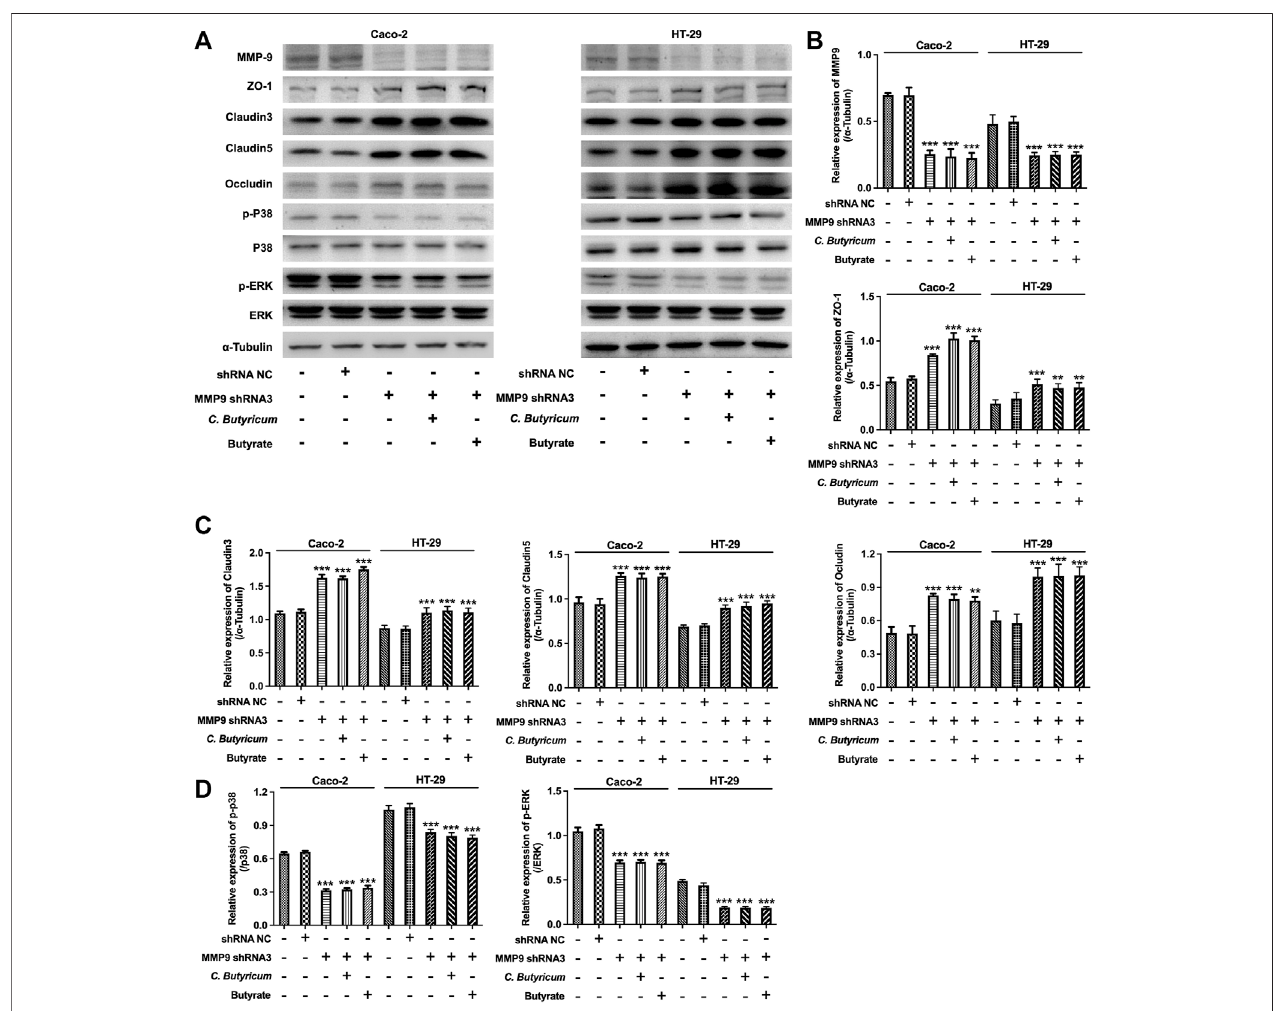
FIGURE 6 | Clostridium butyricum or butyrate could not exert protective roles on intercellular tight junction in MMP9-knockdown Caco-2 and HT-29 cells. (A – D) Caco-2 andHT-29 cellsweretransfected withMMP9shRNA3plasmids. ThetransfectedCaco-2and HT-29cellswerethentreatedwithbutyrate (2 mM forCaco-2cell and 1 mM for HT-29 cell) for 48 h. Meanwhile, the transfected Caco-2 and HT-29 cells were co-cultured with C. butyricum (1 × 10 8 CFU/ml) for 6 h in an anaerobic environment. After that, the supernatant was removed, and cells were then cultured in normoxia environment for 48 h. Western blot assay was used to determine the expressions of MMP9, ZO-1, Claudin3, Claudin5, p-p38, p-ERK in cells. ** p < 0.01, *** p < 0.001 vs. control group. MMP9, matrix metallopeptidase 9; shRNA NC, short hairpin RNA negative control; ZO-1, Zona occludens 1.